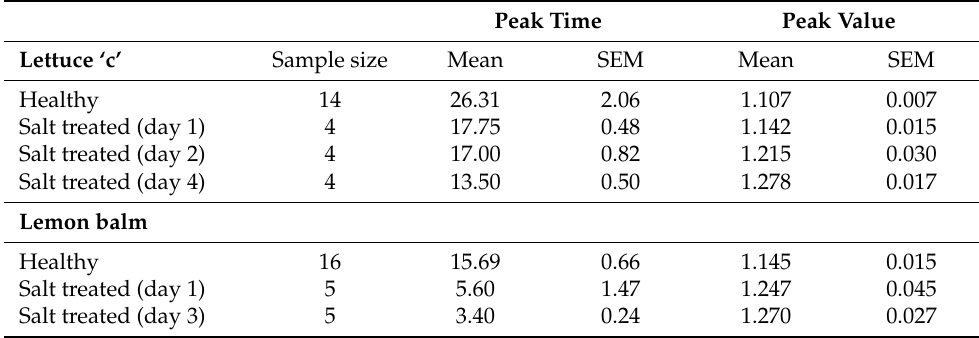
Table 2. The peak time and peak values (mean values and standard error of the mean, SEM) of responses at the lowest background light level, for healthy and salt-stressed lemon balm and lettuce ‘c’. Peak Time Lettuce